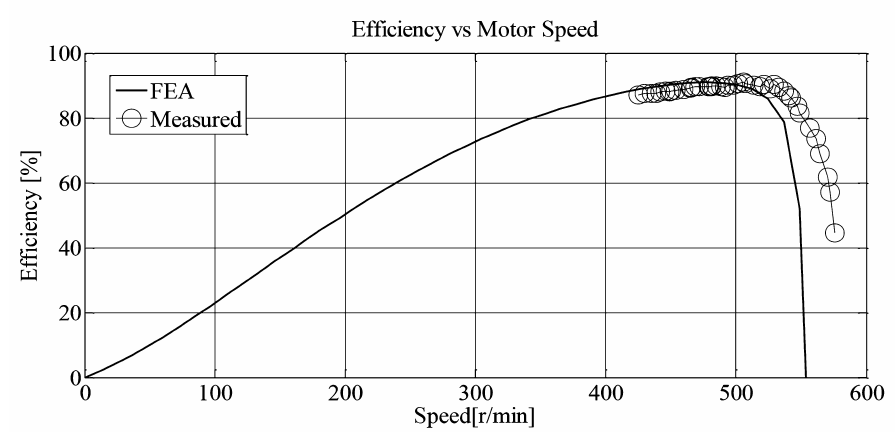
Figure 13. Efficiency versus motor